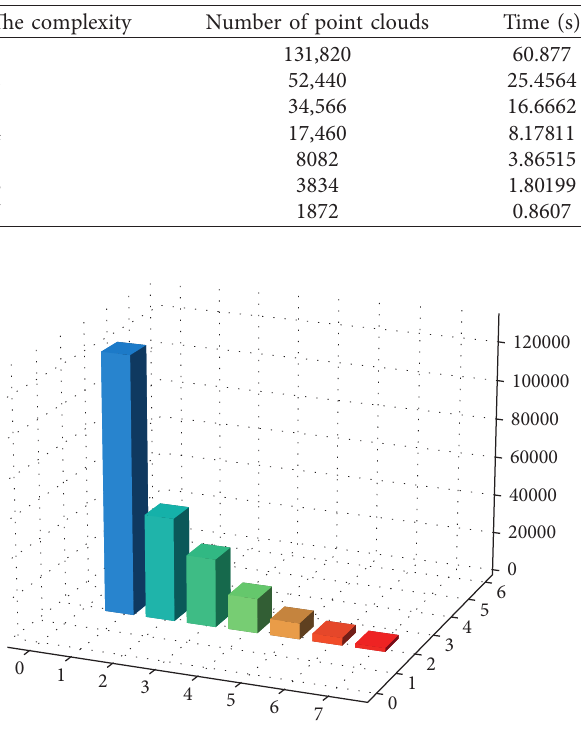
Figure 8: Different complexity of hematoma point cloud amount.